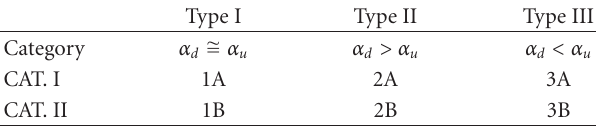
Table 3: Types of road pavement degradation with respect to α d and α u